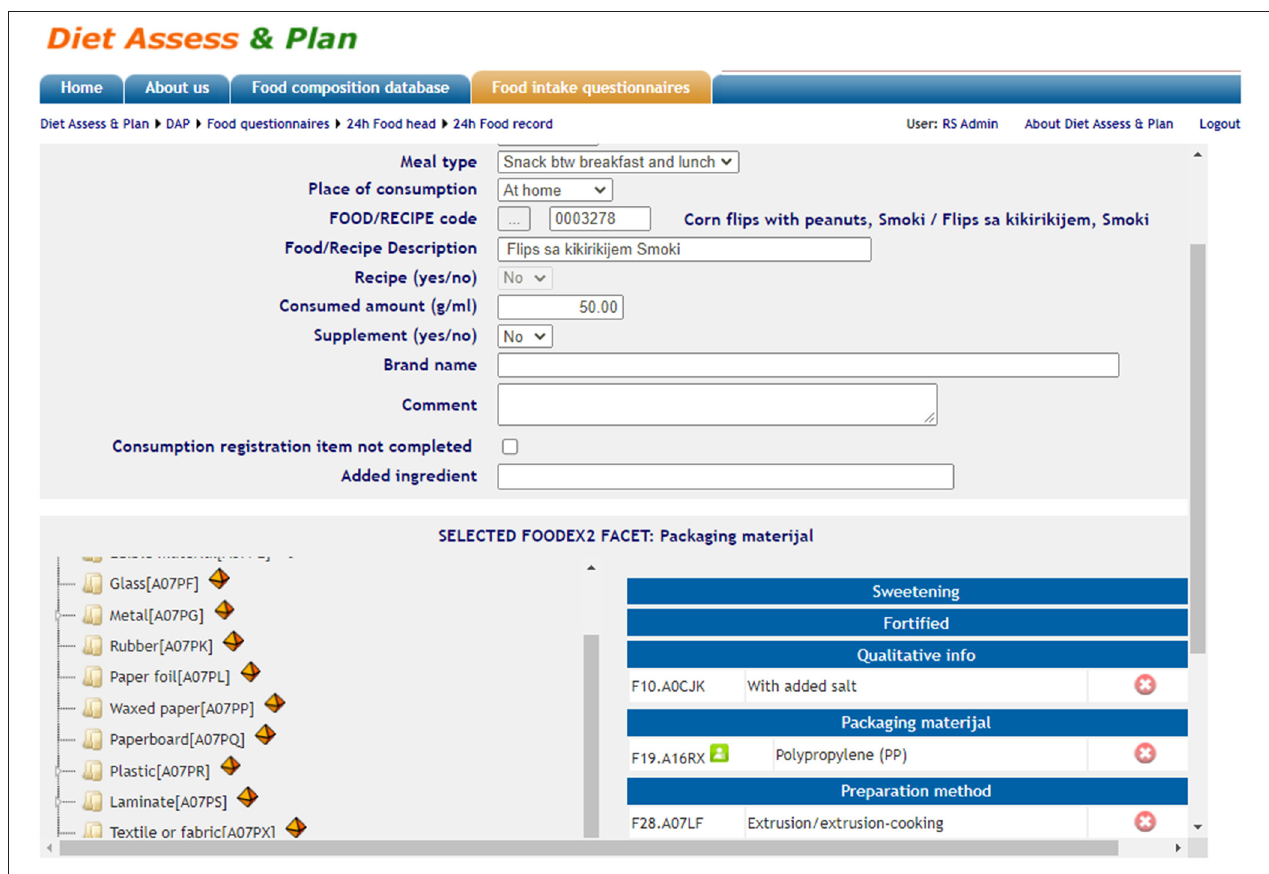
FIGURE 2 | FoodEx2 facet descriptors addition on the level of individual